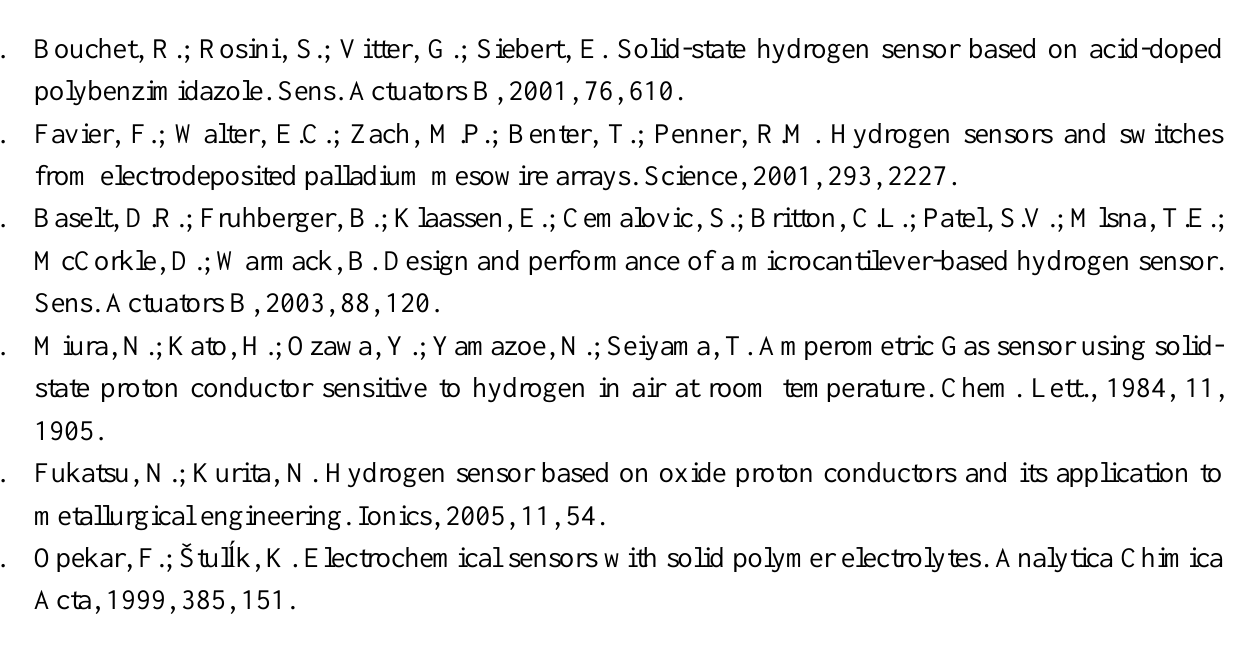
) Cl and 0.01 M KBH 3 4 2 4